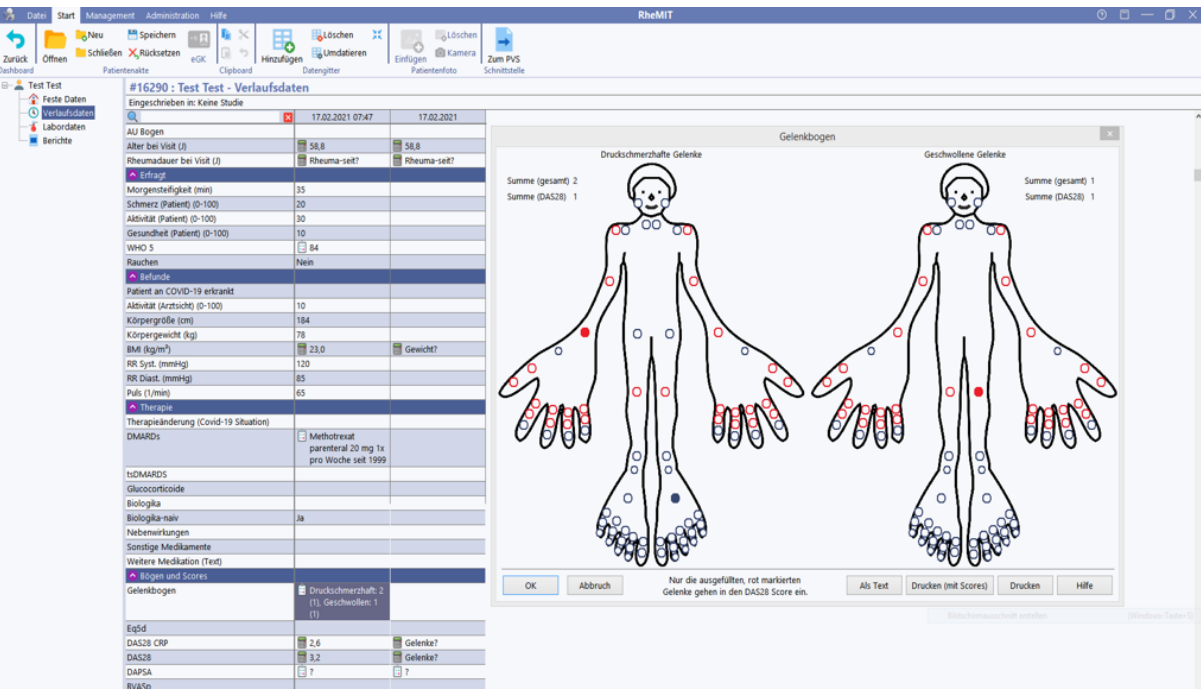
Figure 5. Screenshot of